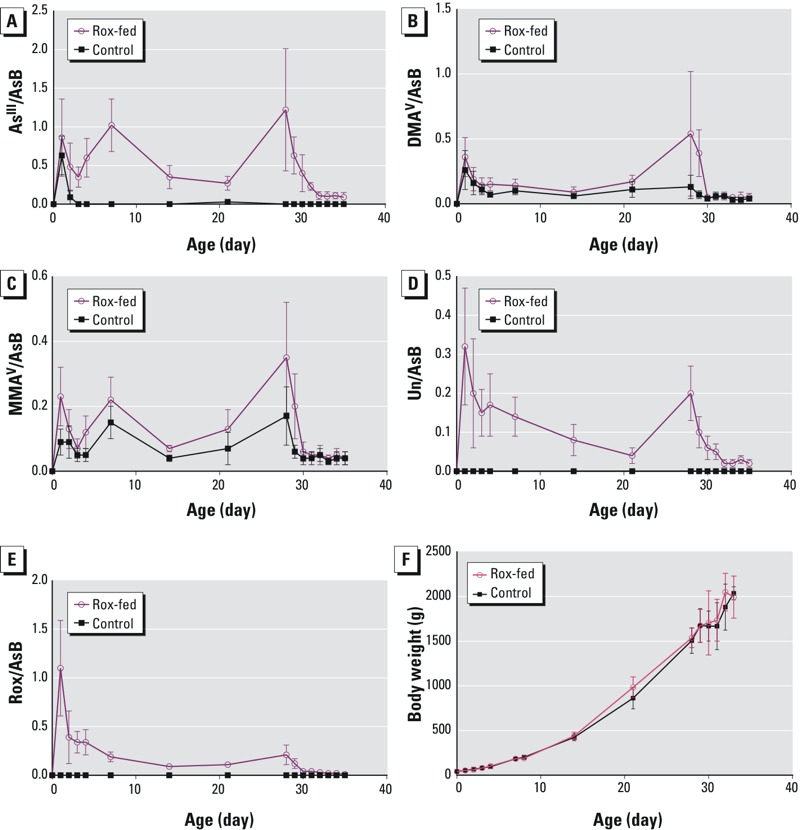
Concentrations of (A) AsIII, (B) DMAV, (C) MMAV, (D) Unknown arsenic species (Un), and (E) Rox, normalized against AsB, in the breast samples of control chickens and Rox-fed chickens over the entire 35-day feeding period. (F) Body weight of chickens over the 35-day feeding experiment. Data represent mean values and error bars represent one standard deviation from duplicate analyses of each of 5–8 chicken samples.